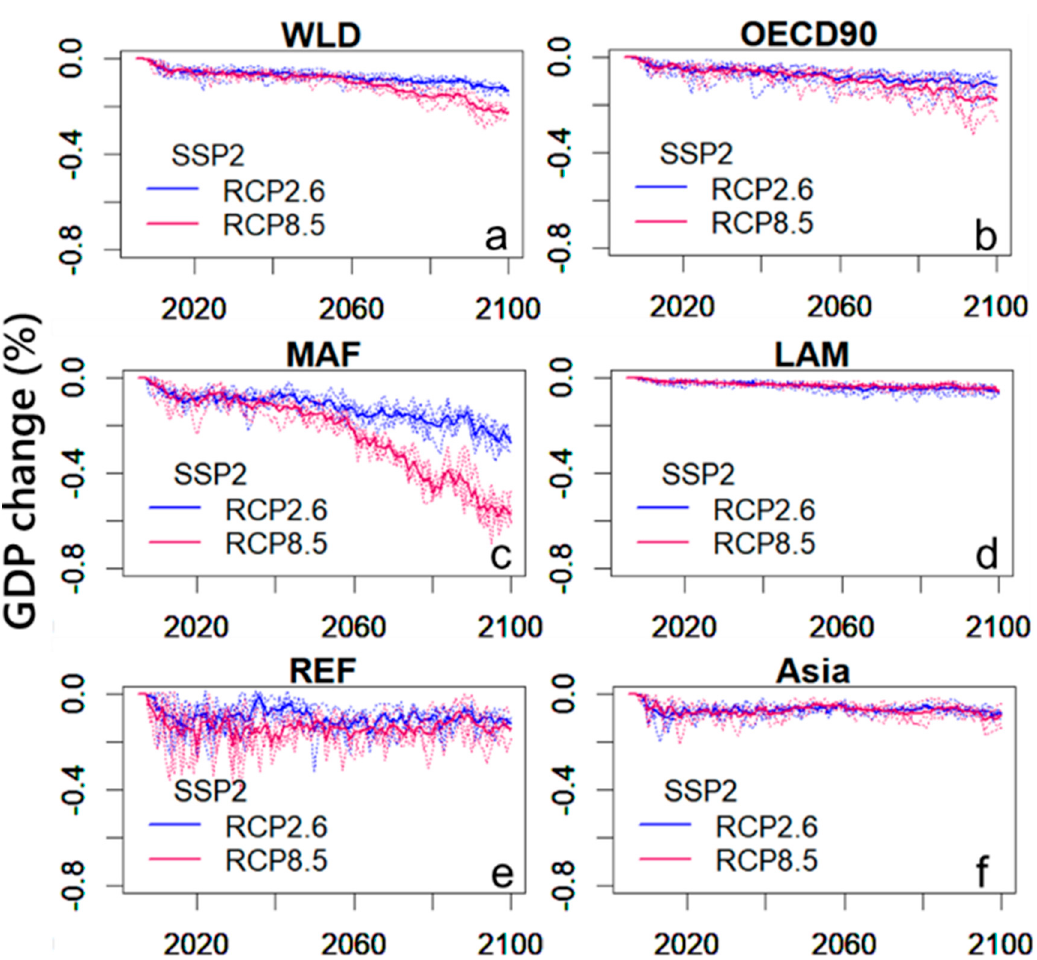
Figure 6. Differences in gross domestic product (GDP) between the RCP2.6 and NoCC runs (blue) and the RCP8.5 and NoCC runs (pink) for ( a ) the WLD, ( b ) OECD90, ( c ) MAF, ( d ) LAM, ( e ) REF, and ( f ) Asia (see Table S1). The thin dotted and bold solid lines show the results using the cooling water insufficiency projected by five individual GCMs and the ensemble mean, respectively.